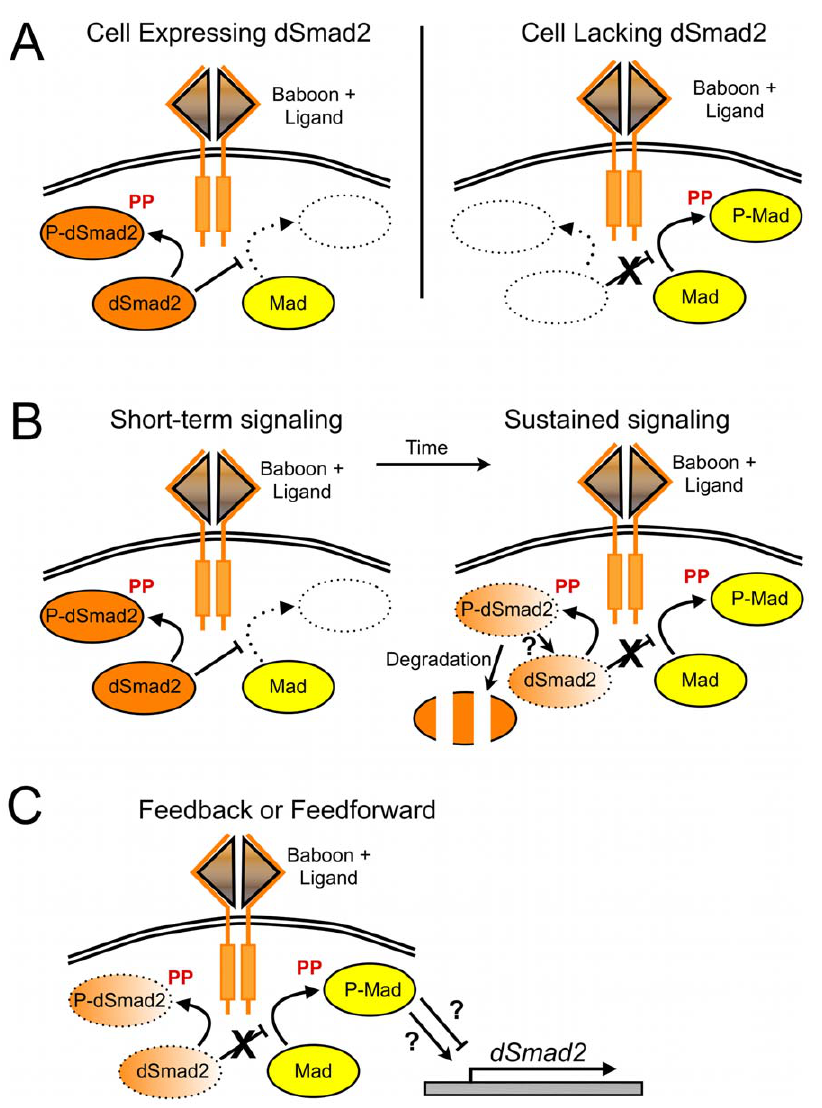
Figure 7. Models of signaling outputs generated by dual kinase activity of the Baboon receptor. Given the potential of Baboon to phosphorylate and activate dSmad2 and Mad, we present several configurations of Baboon, dSmad2 and Mad interaction that would generate different signaling outputs. In each schematic, only the most relevant pathway components are drawn. The first model represents a logic gate, where the ability of Baboon to phosphorylate Mad is strictly controlled by the expression of dSmad2 in that cell (A). Another model incorporates the observed degradation of dSmad2 in response to Baboon signaling (B). The final model (C) incorporates feed-back or feed-forward of Mad activity through dSmad2 regulation. If P-Mad positively regulated dSmad2 this would prevent the complete loss of dSmad2. Conversely, if P-Mad negatively regulated dSmad2 expression, this would enforce the switch from Baboon signaling through dSmad2 towards Mad.